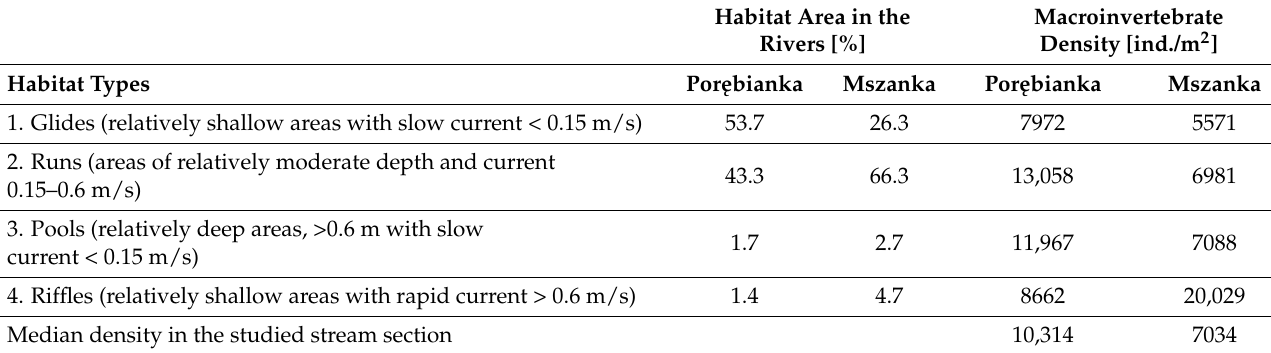
Table 1. Sampled stream channel